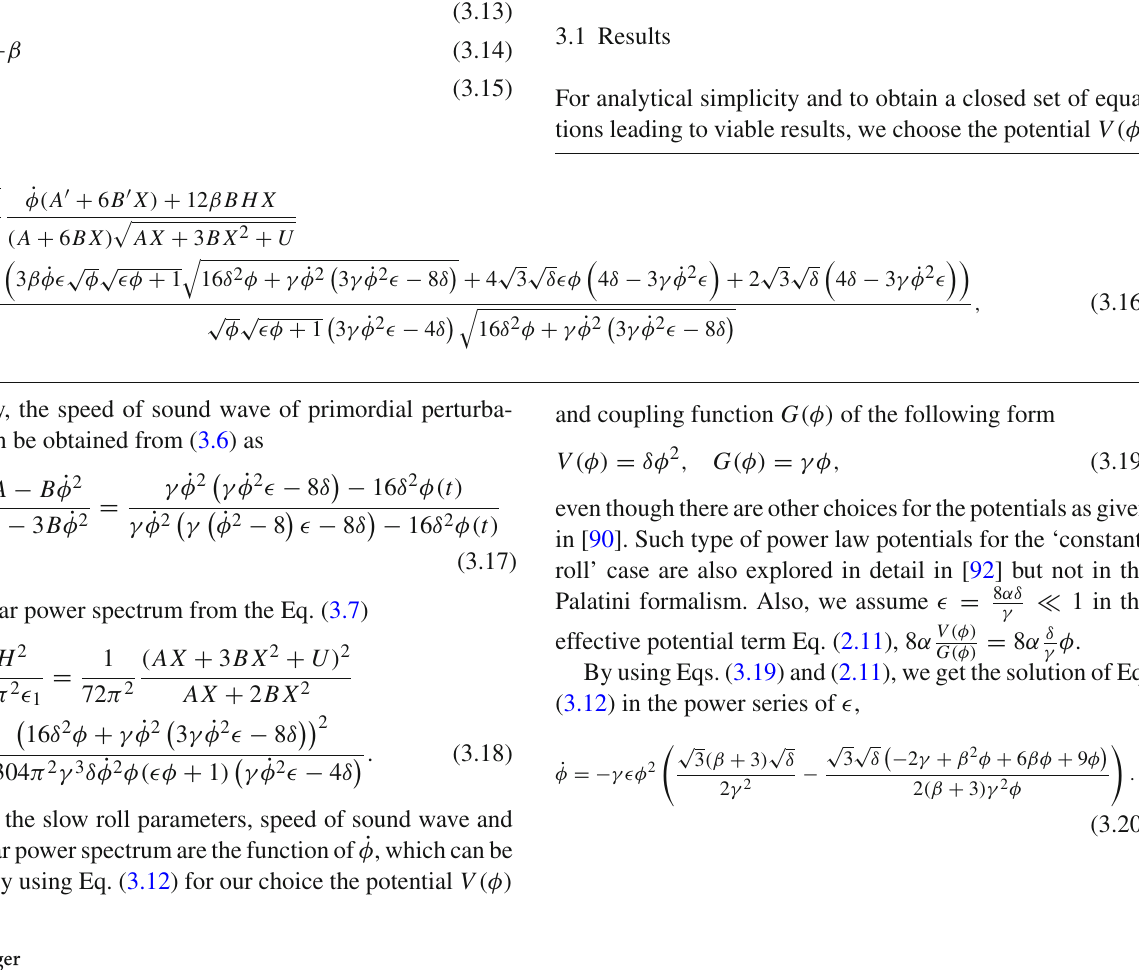
Fig. 1 Phase-space portrayal of the inflation field showing the non- attractor type behavior and coupling function G (φ) . Then, this back to these expressions of (cid:11) ’s, C s and P s